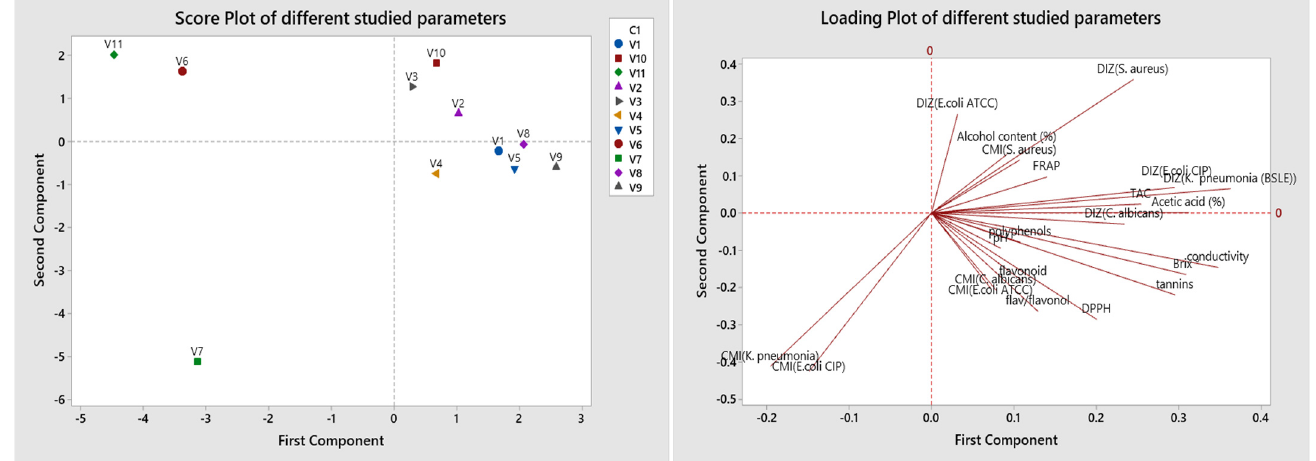
Figure 2. Principal component analysis (PCA) of the various commercialized vinegar samples using the assessed